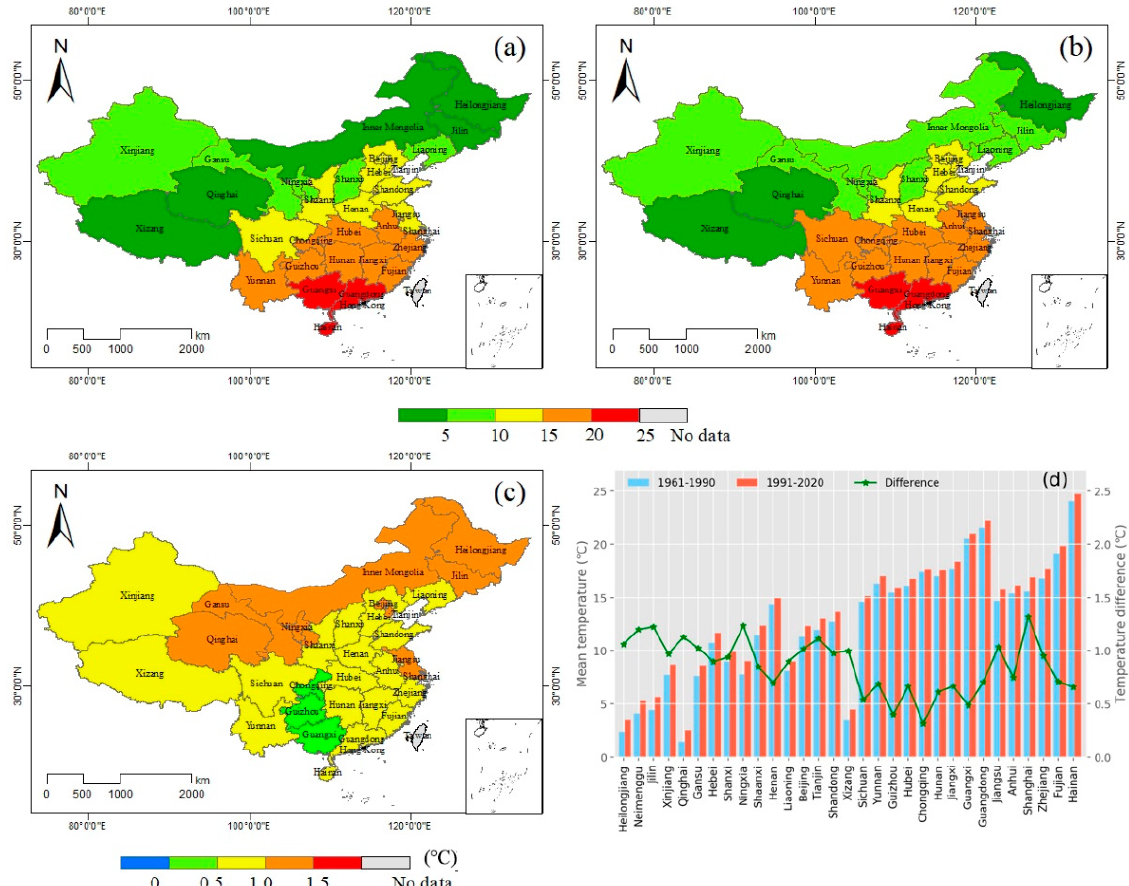
Figure 5. The mean temperature of each province in 1961–1990 ( a ) and 1991–2020 ( b ), and their difference ( c ). Histogram of the mean temperature of each province ( d ).